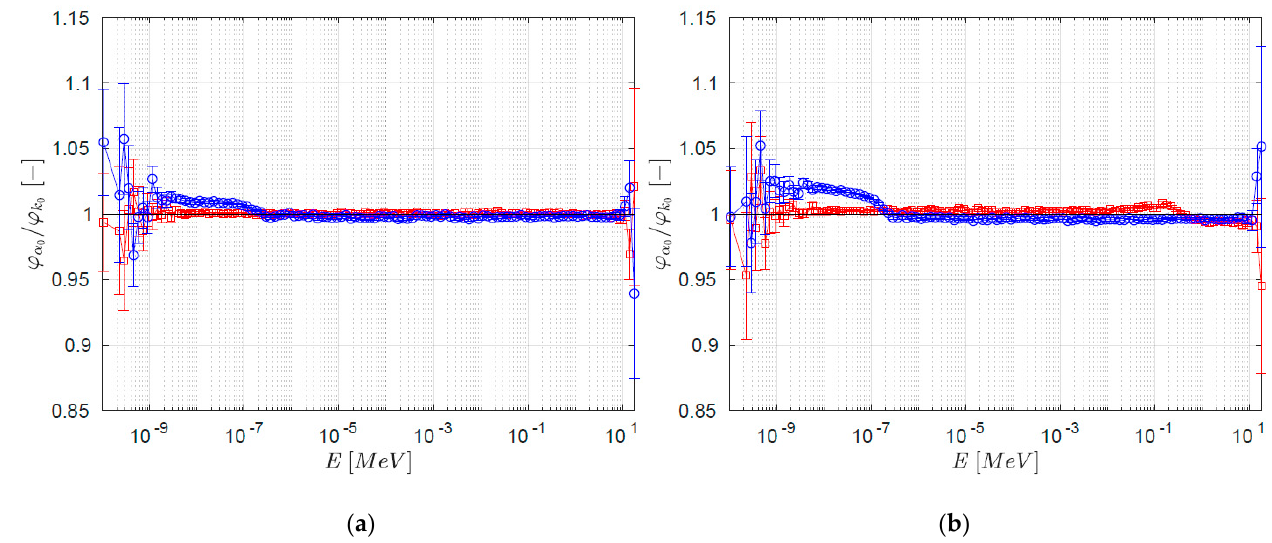
ϕ / ϕ of the CROCUS reactor as a function of the energy variable, H1 ( a ) and H2 ( b ) configurations with (red Figure 13. Ratios α 0 0 k squares) and without (blue circles) precursor contributions.